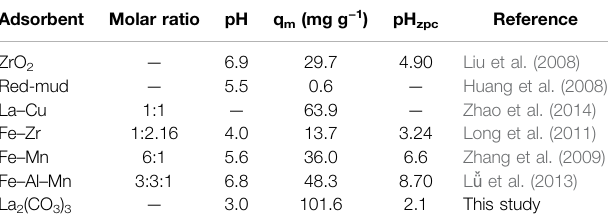
TABLE 1 | Comparison of the maximum adsorption amount of phosphate on various adsorbents. Adsorbent Molar ratio